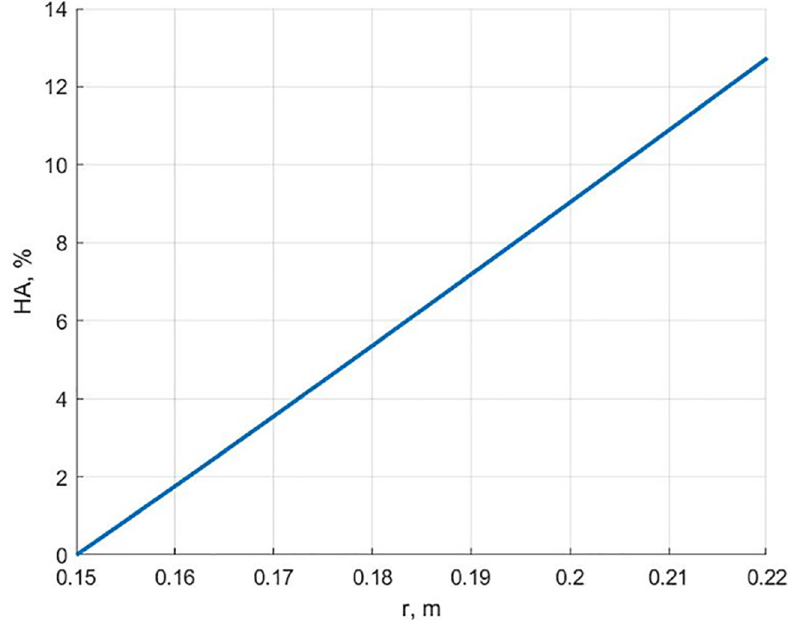
Figure 8. Dependence on the content of hydroxyapatite along the radius for an equally stressed cylinder at the end of the creep process according to the maximum stress failure criterion.